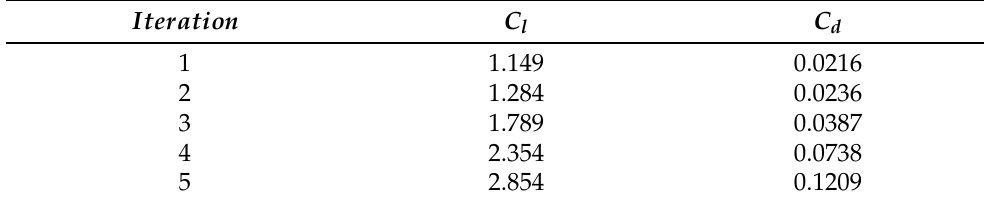
Table 6. Aerodynamic coefficients during the SDO.